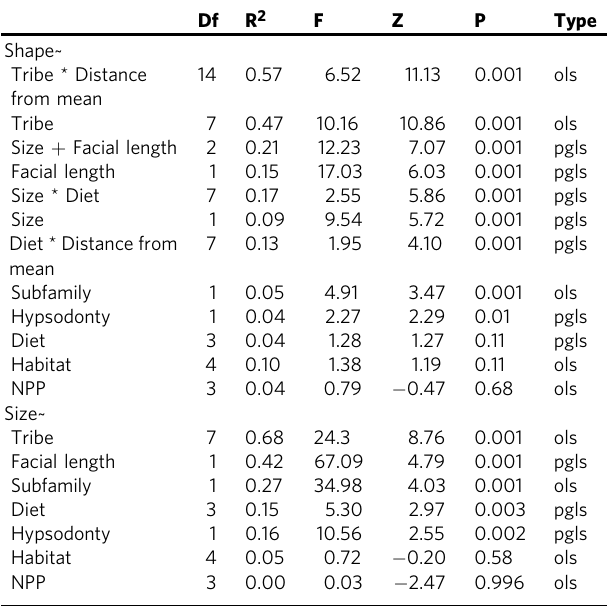
After phylogeny (represented by subfamilial and tribal differences), facial elongation and size provide the strongest explanations of shape, while diet, habitat, and net primary productivity (NPP) are not signi fi cant predictors of shape. Size explains large proportions of the variation in facial length, diet, and hypsodonty. Differences among subfamilies and tribes are of borderline signi fi cance, and differences among habitats and NPP categories are not. All tests with interaction factors (*) have signi fi cant interaction effects (results given in the text). pgls (phylogenetic least squares) tests take phylogeny into account while ols (ordinary least squares) tests do not. Tests with tribe, hypsodonty, habitat, and NPP use reduced species subsets. Results sorted by Z score (effect